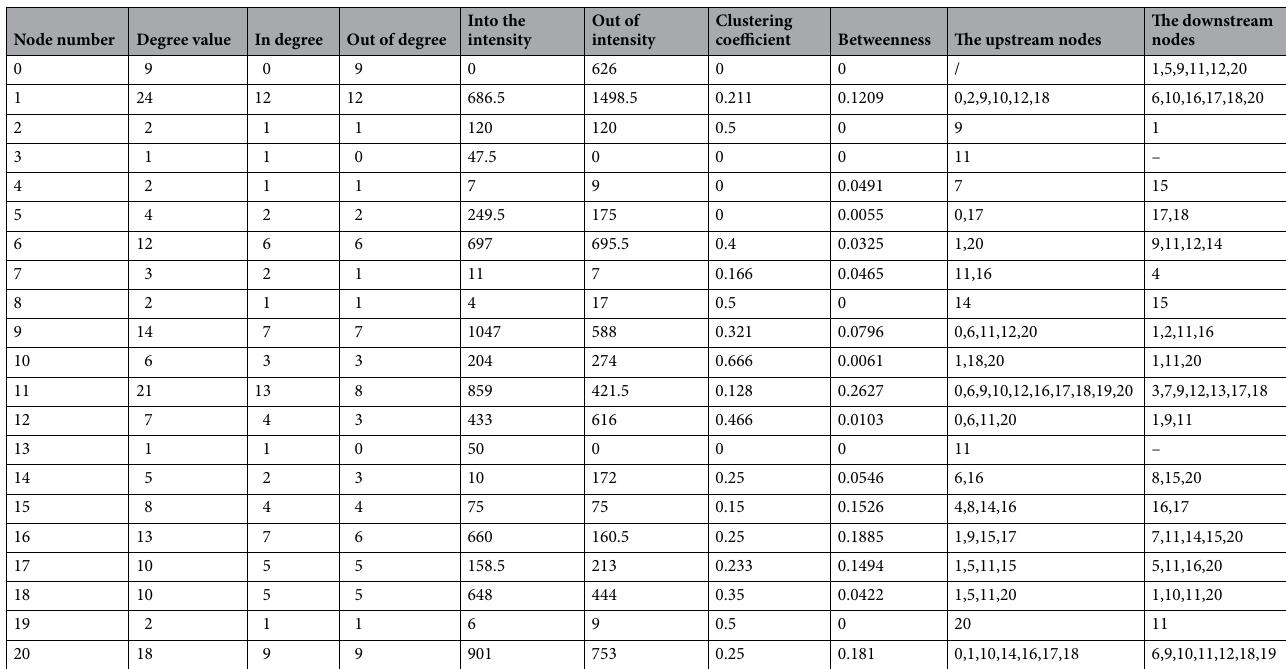
Table 3. Network parameters of production network equipment node in